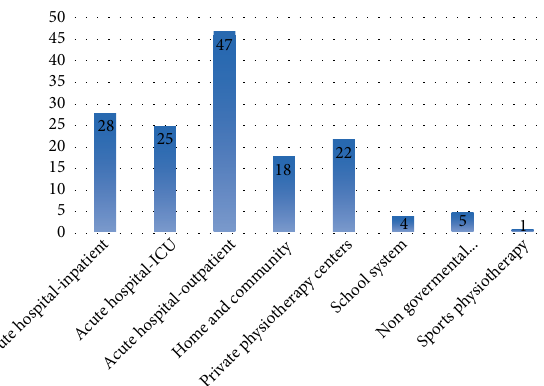
Table 1: Characteristics of respondents.